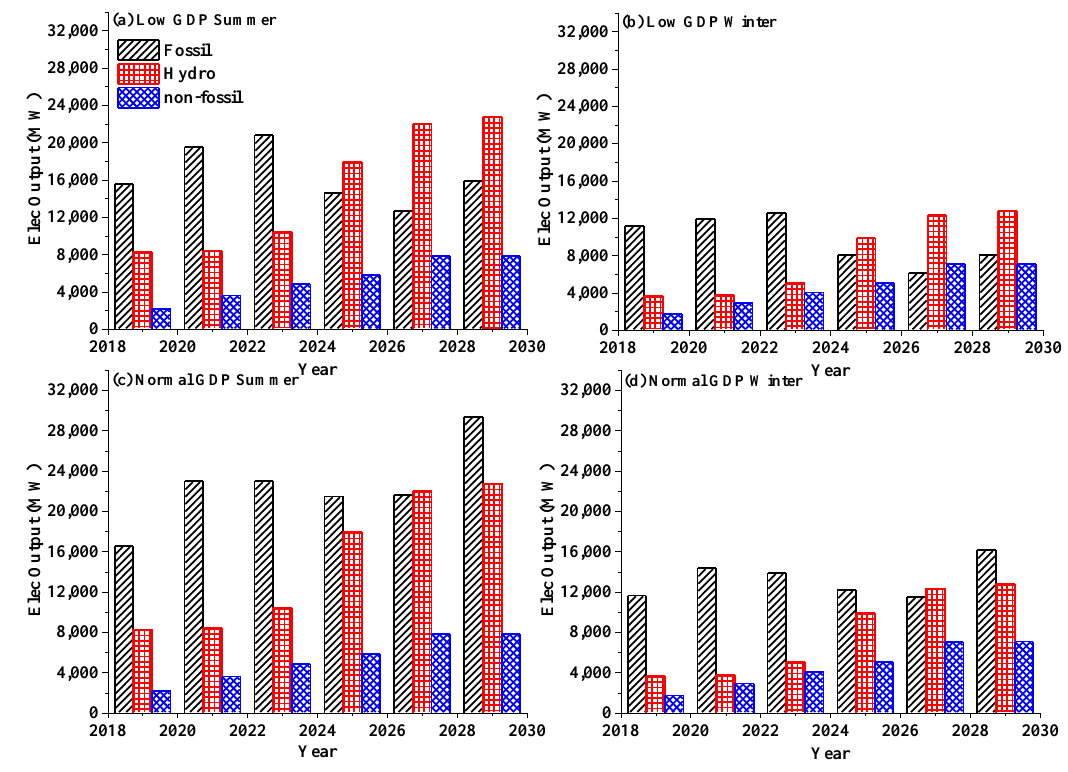
Figure 8. Optimal energy mix at the reference case.